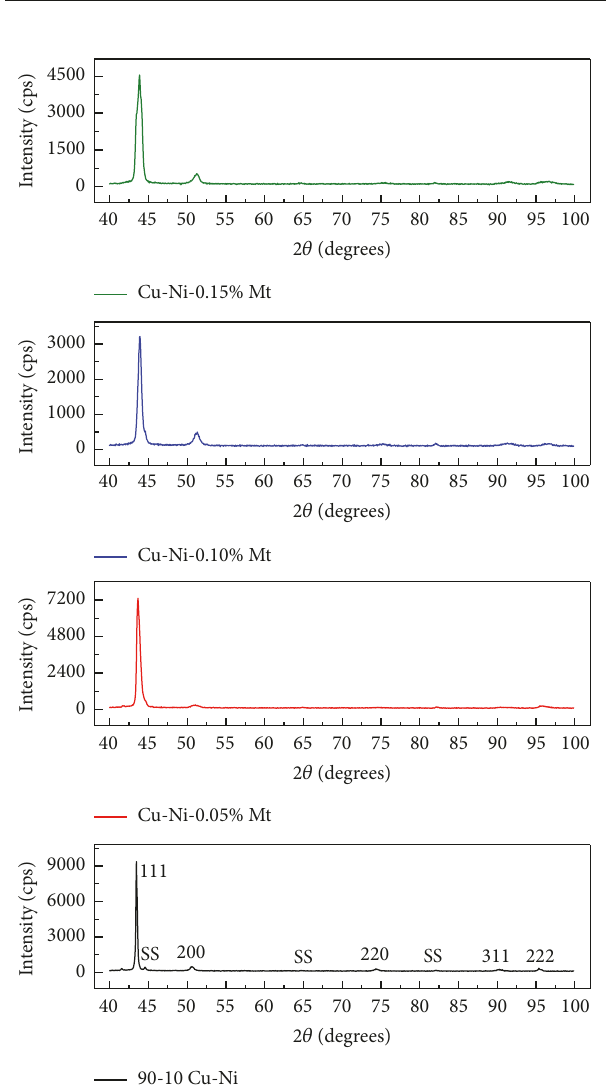
Figure 3: X-ray diffraction patterns of 90-10 Cu-Ni and Cu-Ni-Mt nanocomposite coatings run from 40–100 ∘ 2 𝜃 at a step size of 0.05 ∘ and dwell time of 1sec (ss: steel